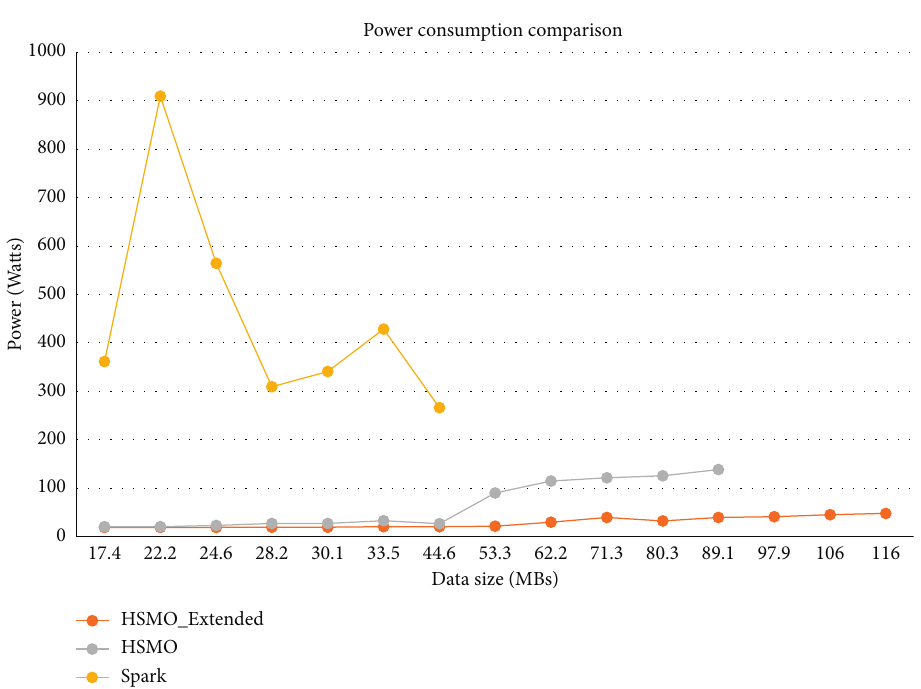
Figure 11: Power consumption comparison for different